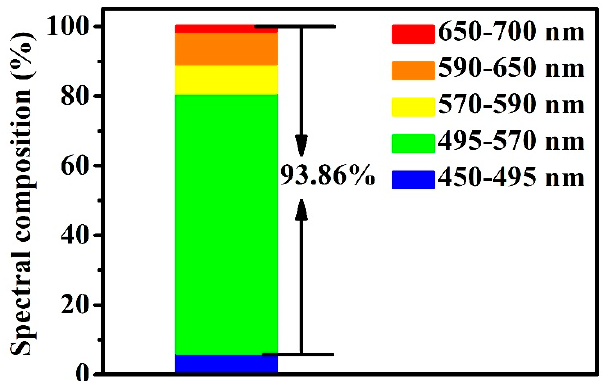
Figure 8. The red–green–blue spectral composition of g-CQDs (V (EDA) = 4 mL, T = 180 ◦ C, D r = 12 h). With their excellent optical performance, g-CQDs were combined with a blue light chip to prepare white LEDs in order to further explore the potential application of g-CQDs in white LEDs. LEDs mainly consisted of a blue chip, gold wire, optical lens, and electrode, as shown in Figure 9a. The blue light chip was the excitation light, and the optical lens coated with g-CQDs was the white light converter. One end of the chip was connected to the cathode of the power source and the other end was connected to the anode. When the current was applied, a p–n junction would be formed, which promoted electron-hole recombination and photon release energy. Subsequently, g-CQDs absorbed the excited light from the blue light chip and re-emitted visible light, and finally converted blue light into white light [6]. The emission spectrum of white LEDs was recorded.